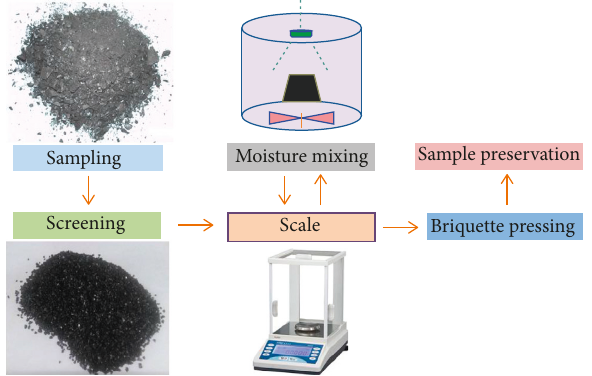
Figure 2: Humidification process of the coal